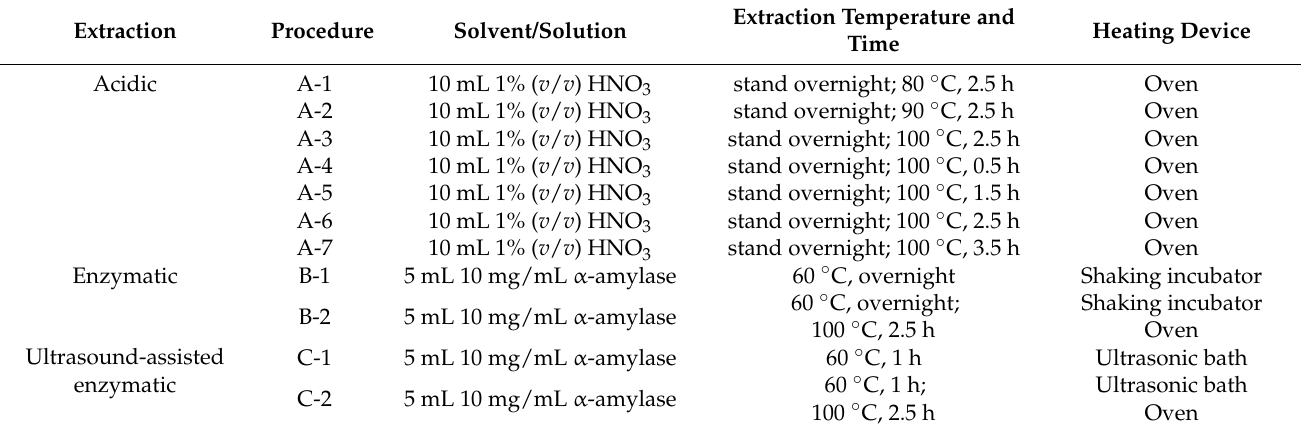
Table 2. Extraction conditions evaluated in this